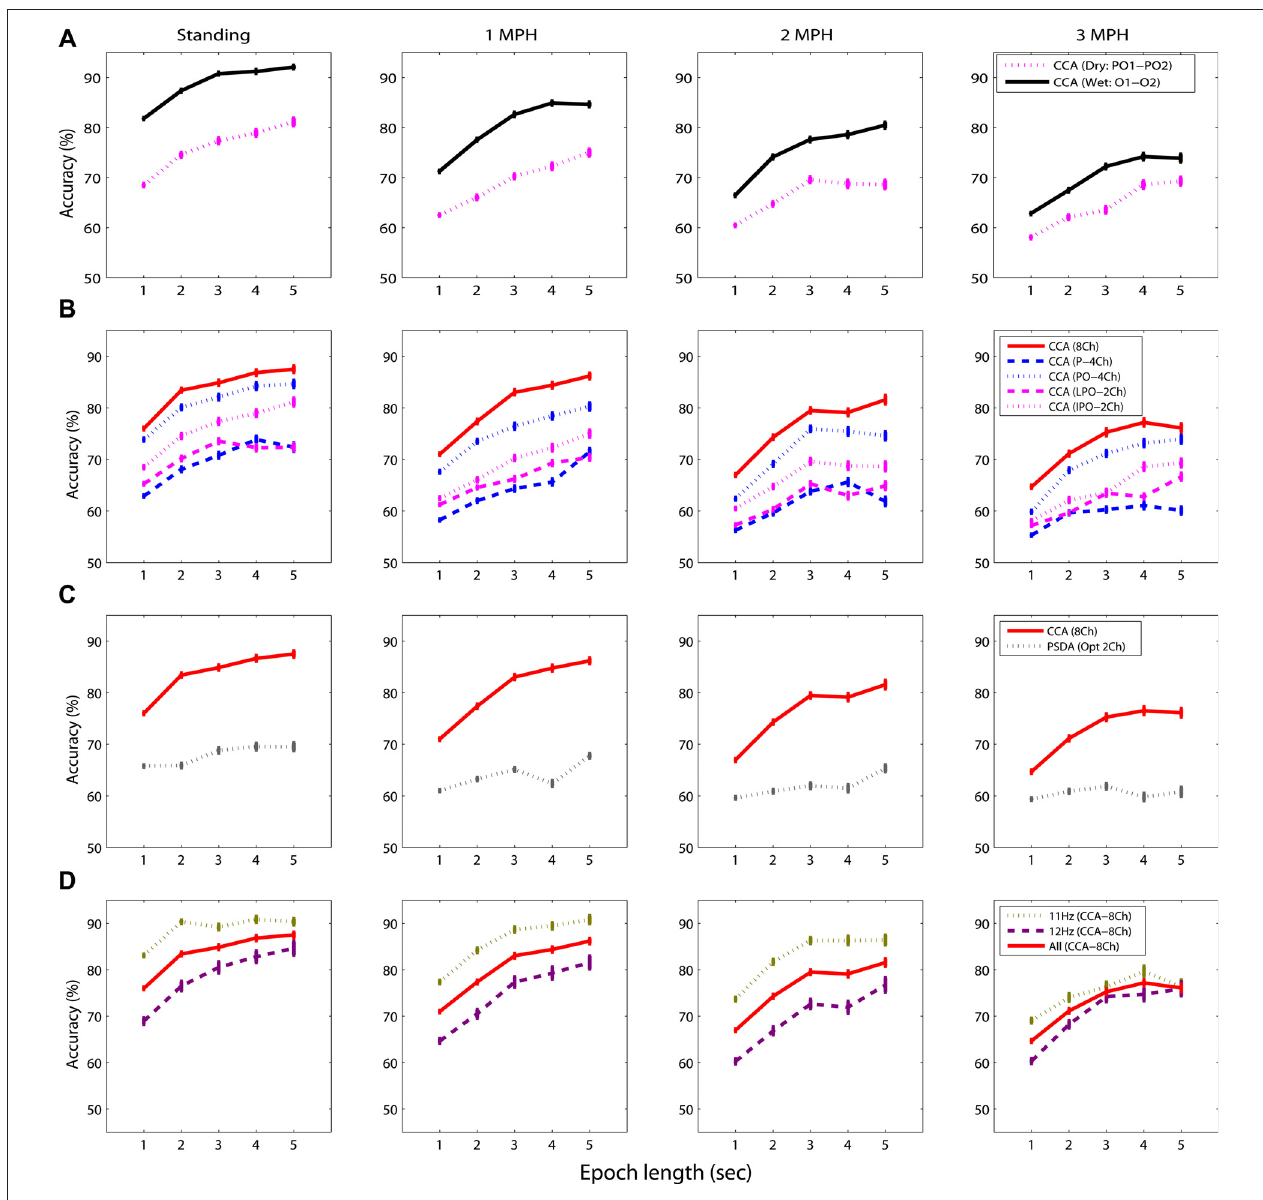
FIGURE 4 | The comparative results for evaluating the factors dominating the SSVEP detectability while standing still or walking with different speeds (1–3 MPH), including (A) electrode